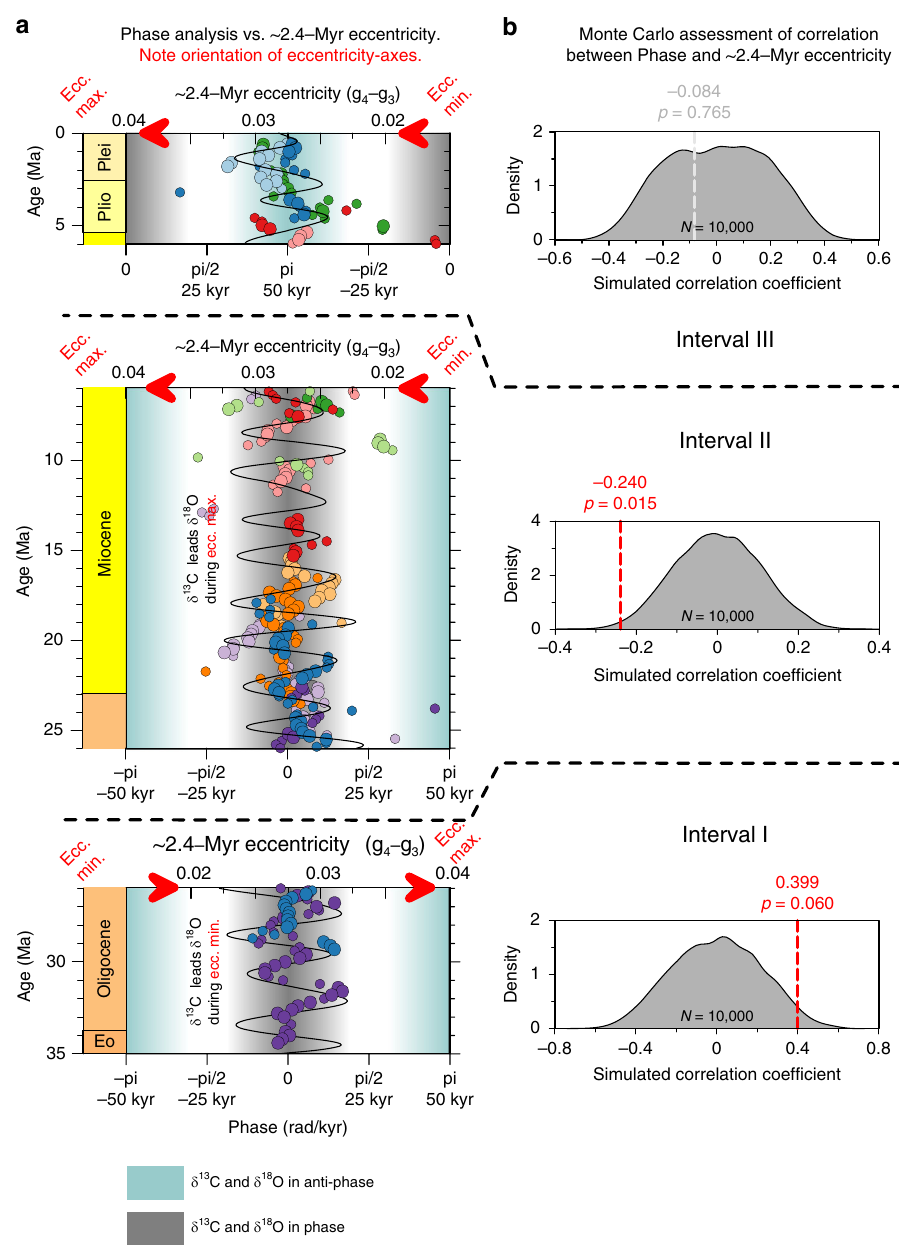
Fig. 3 Long 2.4-Myr eccentricity ( g 4 − g 3 ) modulates Oligocene and Miocene leads and lags between δ 13 C and δ 18 O on 100-kyr eccentricity time- scales. a Visual comparison of phase analysis results and 2.4-Myr eccentricity cycles, only considering phase-results with coherence >0.3 (see Fig. 2). b Prior to 26 Ma (Interval I), long 2.4-Myr eccentricity minima correlate with time-intervals when δ 13 C leads δ 18 O (positive Spearman correlation coef fi cient of 0.399 between phase and eccentricity). Between 26 and 6 Ma (Interval II), long 2.4-Myr eccentricity minima correlate with time intervals when δ 18 O leads δ 13 C (negative Spearman correlation coef fi cient of − 0.240). After 6 Ma (Interval III), the correlation between 2.4-Myr eccentricity and phase ceases ( R = −